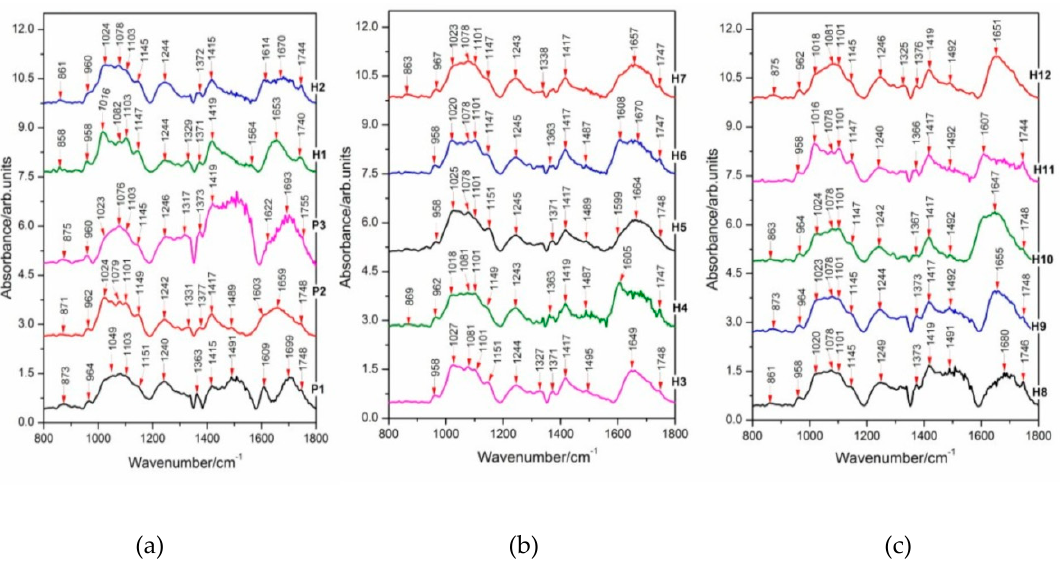
Figure 4. FT-IR absorbance spectra of DNA extracted from different Streptocarpus parents and their hybrids: ( a ) P1, P2, P3, H1, and H2; ( b ) H3, H4, H5, H6, and H7; and ( c ) H8, H9, H10, H11, and H12. All spectra were acquired over 256 scans. Spectra were scaled to have the same intensity in the 1101 cm − 1 ( υ s PO 2 − ) band. Profiles are presented in the wavenumber range 800–1800 cm − 1 .